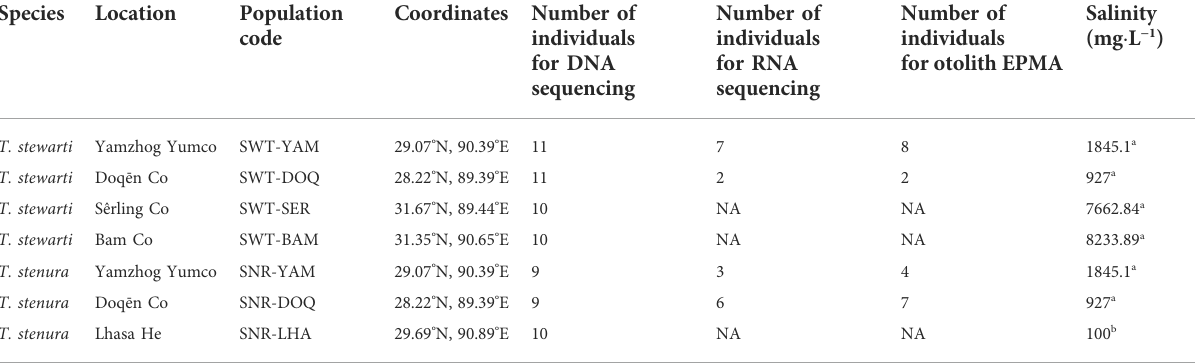
TABLE 1 Sampling information of populations used in this